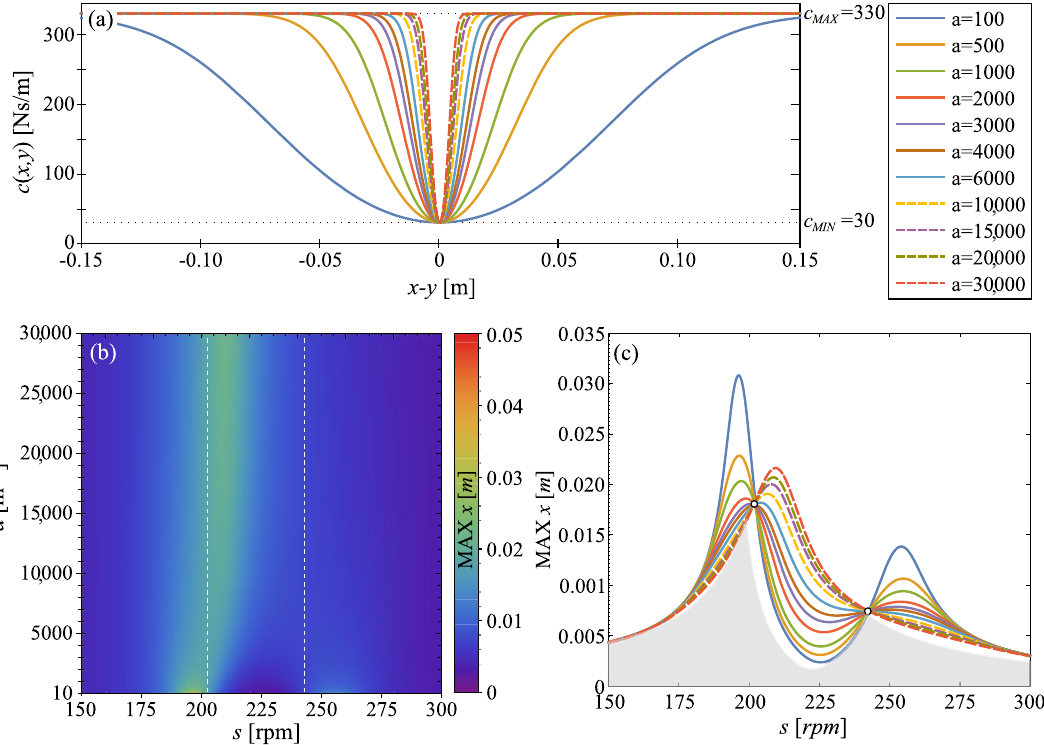
Figure 3. In panel ( a ) we show the damping functions c ( x , y ) (Equation (3)) for selected values of a . In panel ( b ) we show two dimensional plot of maximum amplitude of damped system (max x [ m ] ) in two parameters of space: a and s . The last panel ( c ) shows eleven exemplary FRCs of the damped